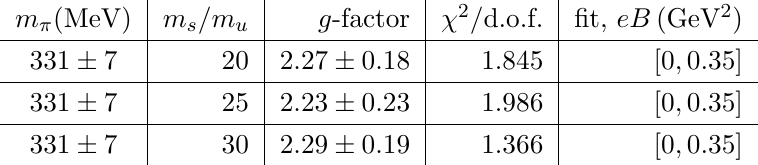
Table 2. The g-factor of the K (cid:3)(cid:6) meson, obtained on the lattice with the volume 18 4 , the lattice spacing 0 : 115 fm and various bare masses of the light and strange quarks. The values of (cid:31) 2 /d.o.f. and intervals choice for the (cid:12)tting procedure are also